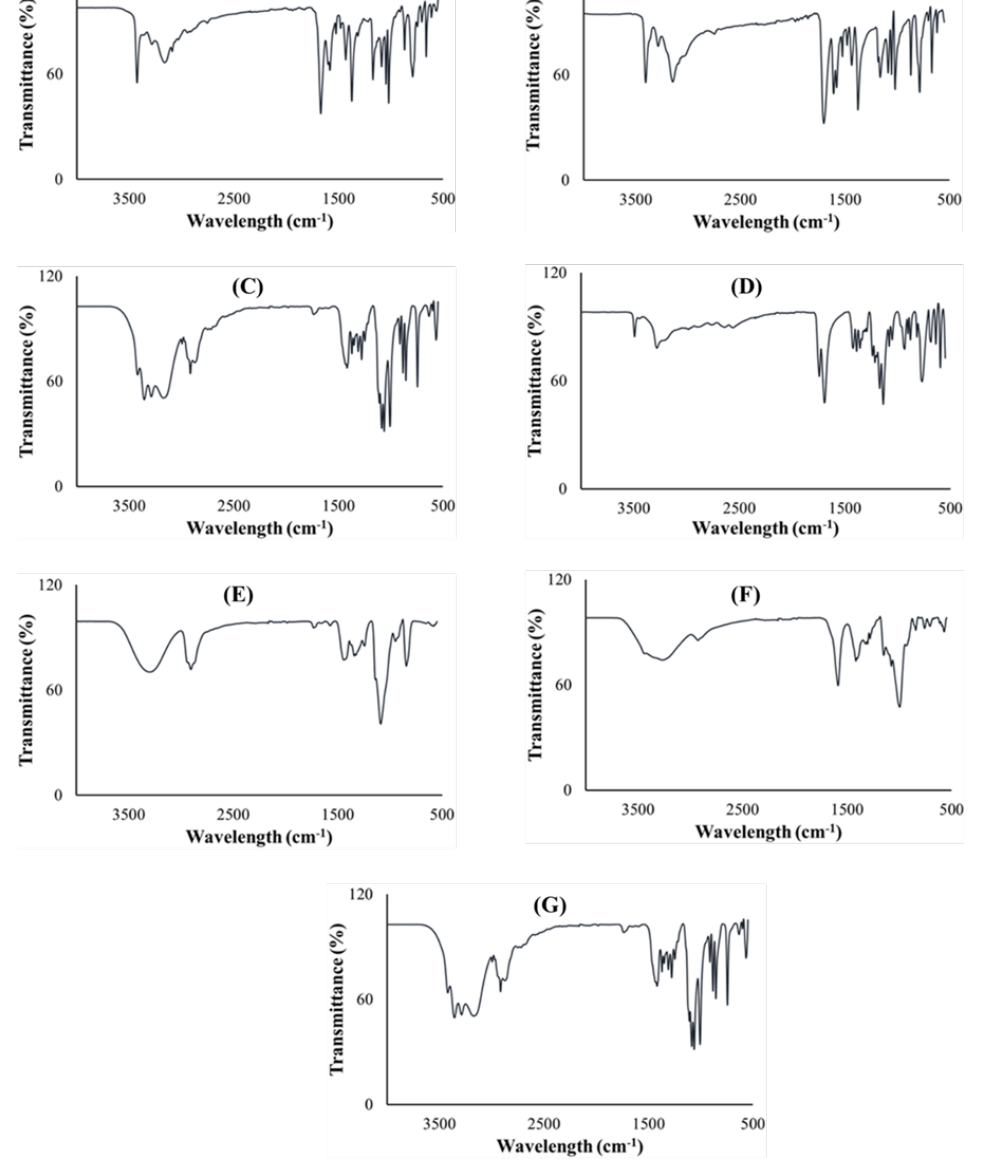
Figure 6. FTIR spectra of ( A ) xylitol, ( B ) sodium starch glycolate, ( C ) citric acid, ( D ) polyvinyl alcohol polyethylene glycol, ( E ) PZA, ( F ) drug loaded formulation and ( G ) placebo.